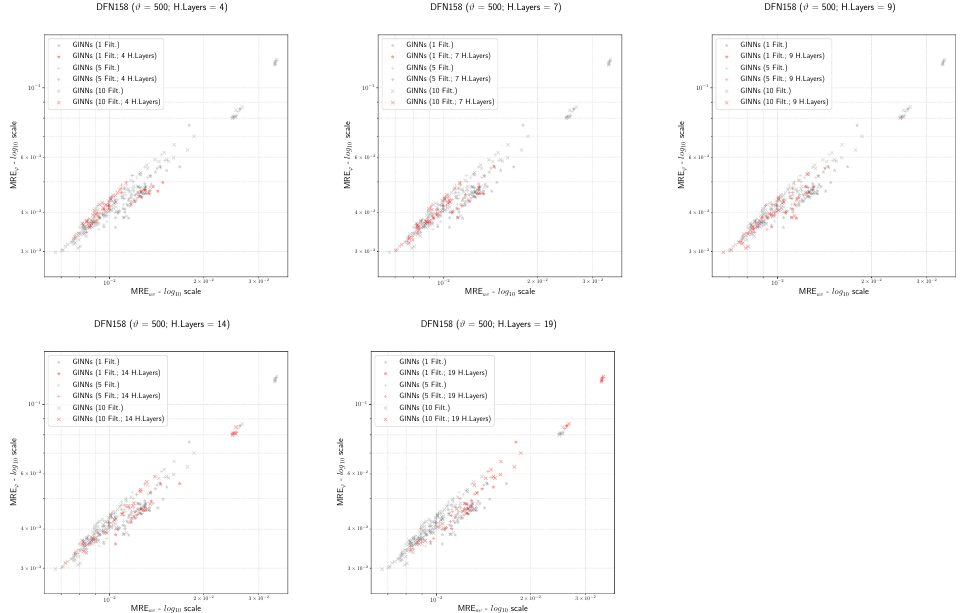
Figure 14. Scatter plots in the ( MRE av ,MRE ϕ ) plane for GINNs trained with respect to DFN158, ϑ = 500. Left to right, top to bottom: red markers highlight GINNs trained with H = 4,7,9,14,19, respectively (black markers for all the other